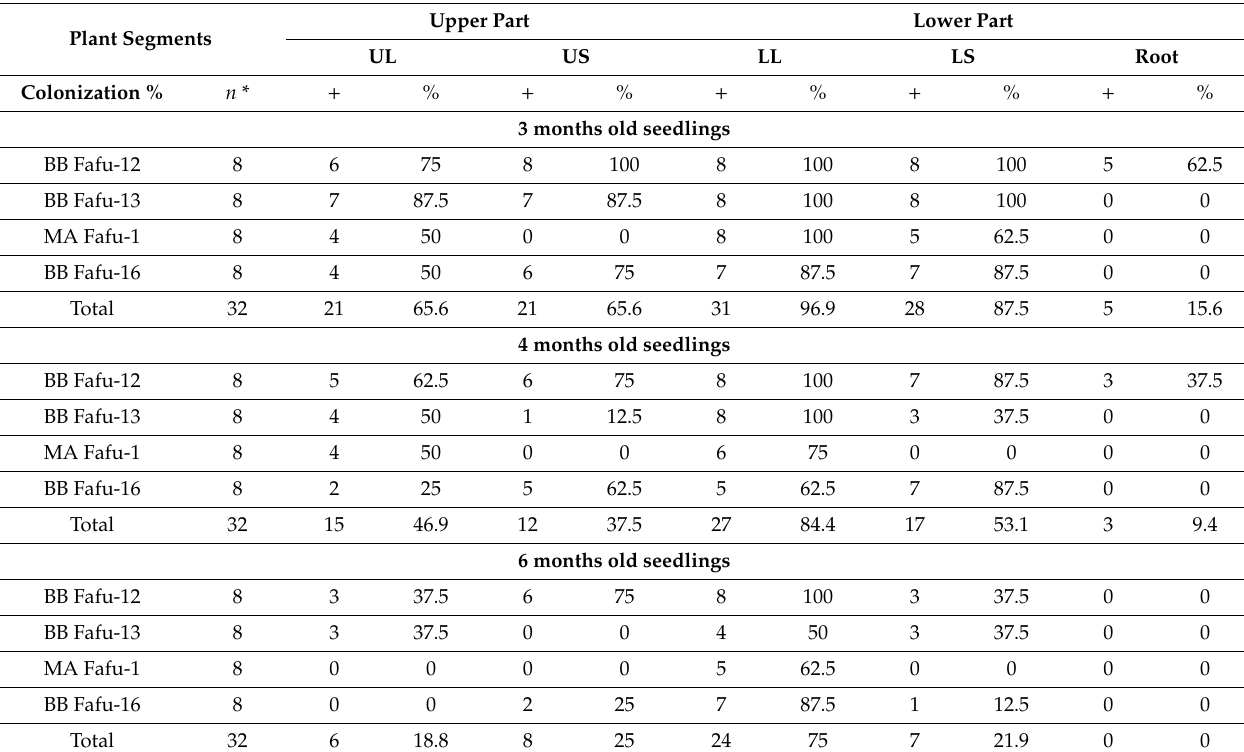
Table 2. Colonization frequency of entomopathogenic Beauveria bassiana strains (BB Fafu-12, BB Fafu-13, and BB Fafu-16) and Metarhizium anisopliae (MA Fafu-1) in di ff erent plant segments (leaf, stem, and root) following foliar inoculation of 3, 4, and 6 months old citrus plants with 1 × 10 8 conidia mL − 1 of each of the treated fungal